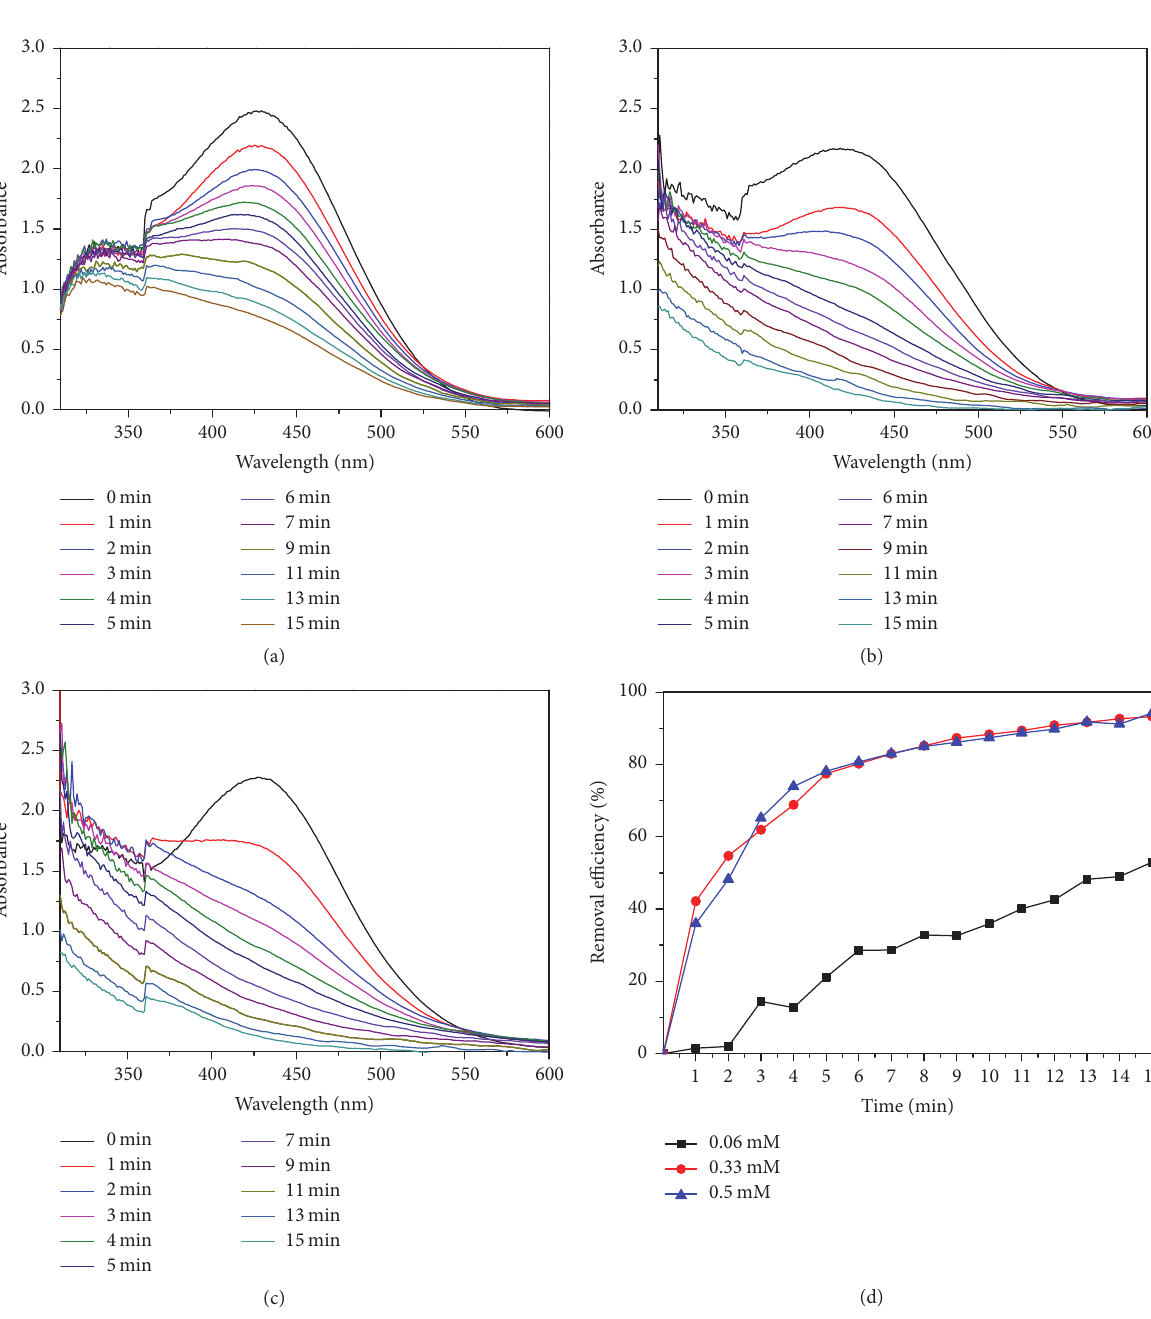
Figure 5: The UV-Vis spectra of bromothymol blue over time with different concentration of GZVINPs, (a) 0.06 mM, (b) 0.33 mM, (c) 0.5 mM, and (d), and the degradation of bromothymol